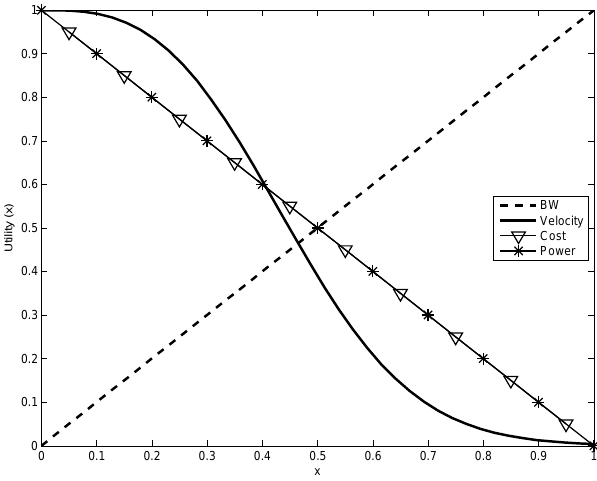
Figure 4. Example of Utility Functions compare the delays and bandwidth of each RAT. If the RAT values do not meet the required reference for a specific application z , the RAT is eliminated. Otherwise, Figure 3. Shim Layer Flowchart they are validated to the next stage and a score is allocated based on the utility function from Fig. 4